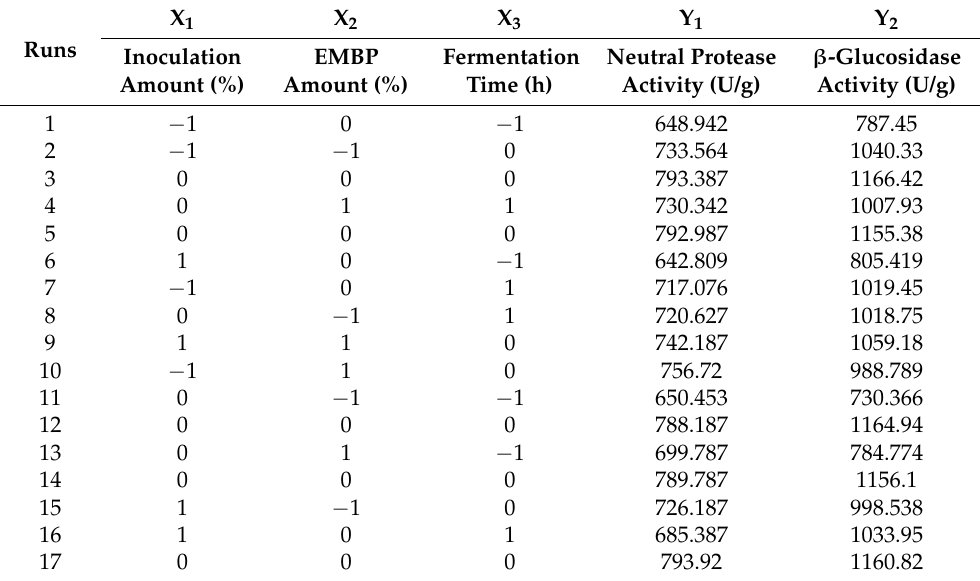
Table 2. Experimental results for Box–Behnken design.